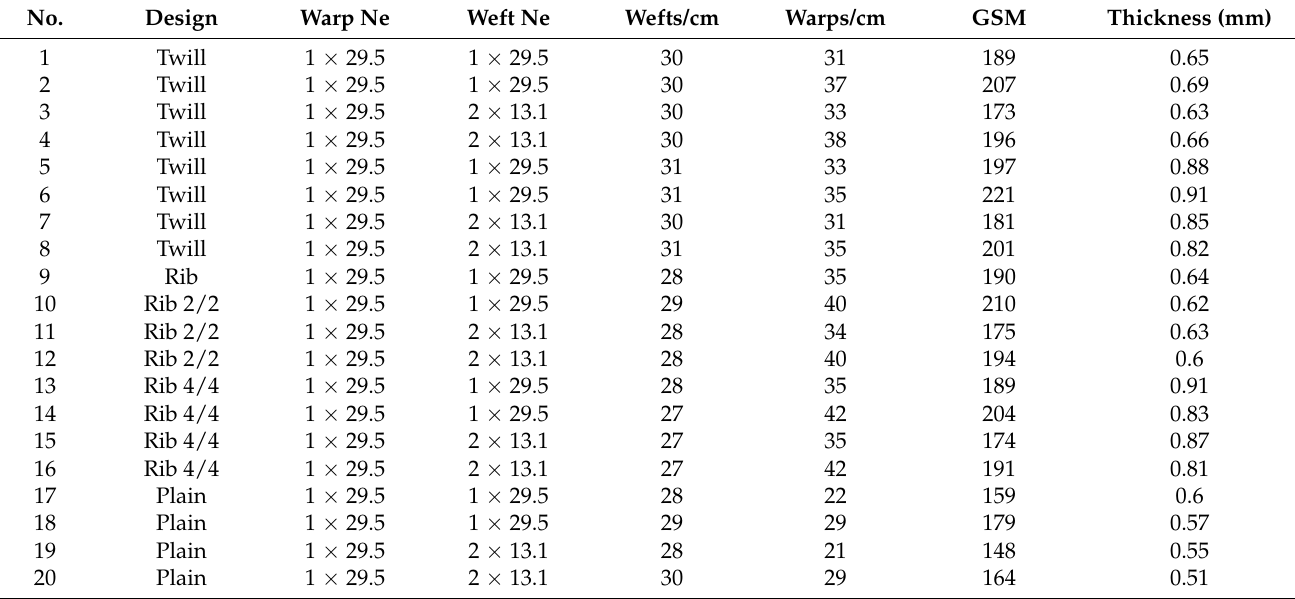
Table 2. 20 Fabric specifications produced from the same cotton